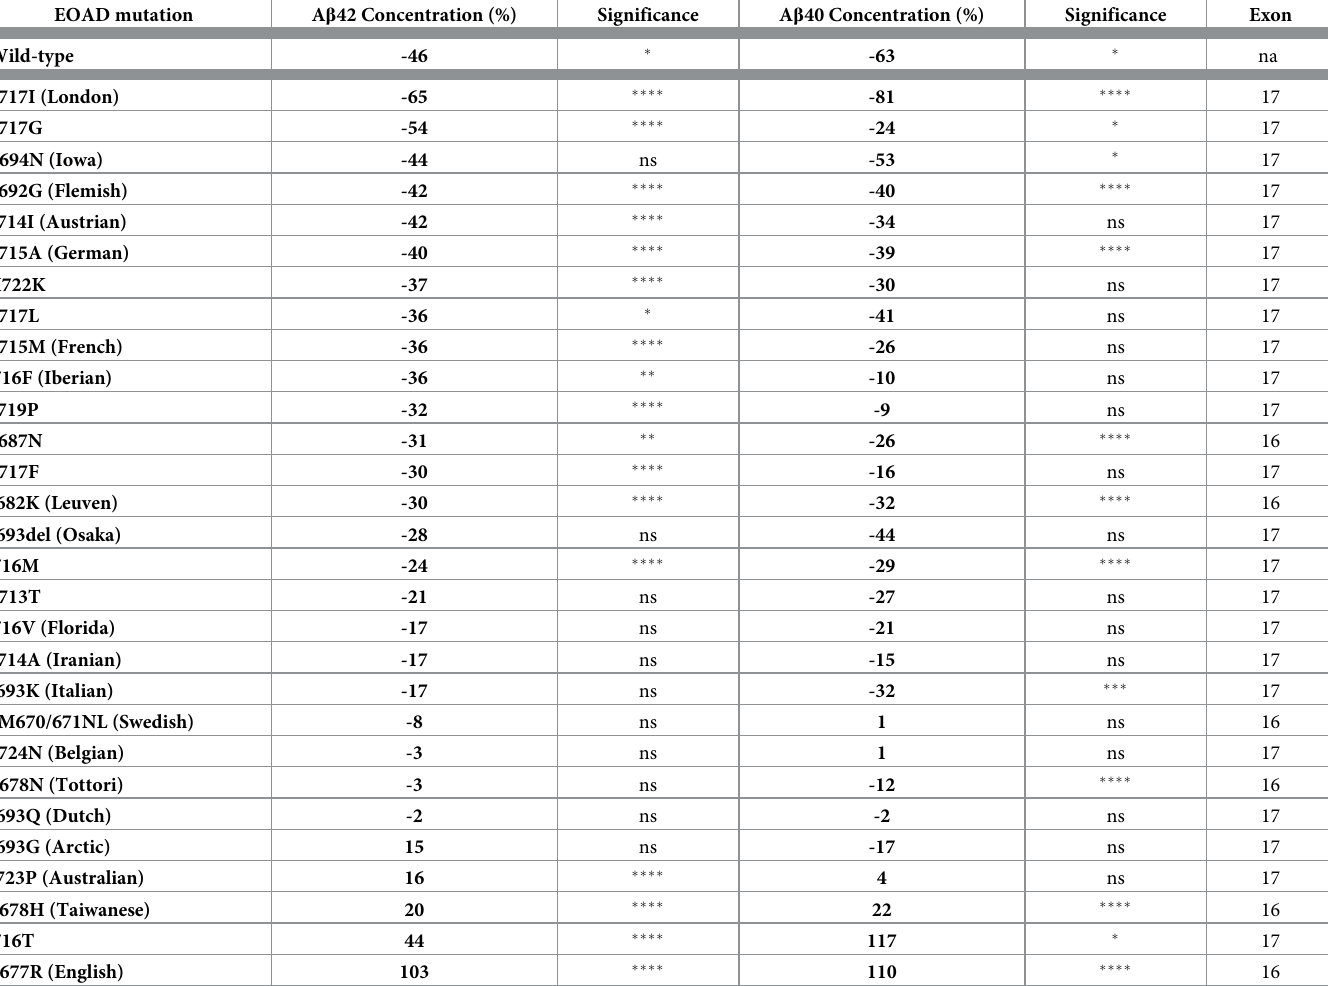
Table 1. Percentage variations in A β 40 and A β 42 peptide concentrations due to the A673T insertion. EOAD